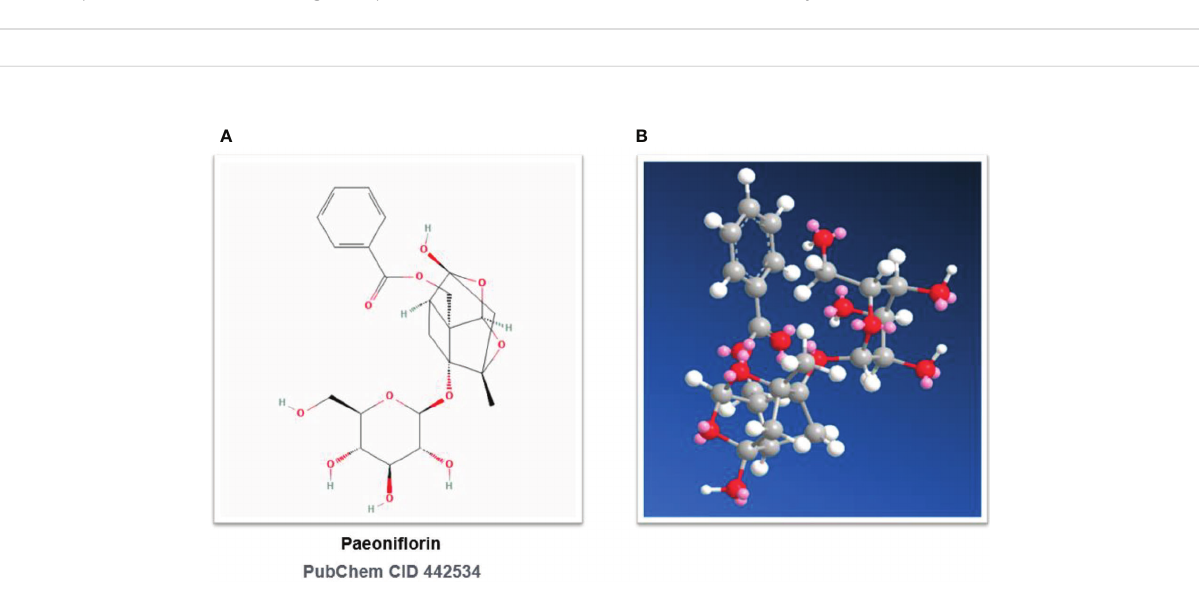
FIGURE 3 Chemical structures of paeoni fl orin. (A) Paeoni fl orin: 2D Chemical Structural Formula. (B) Paeoni fl orin: 3D Chemical Structural Formula. PubChem CID